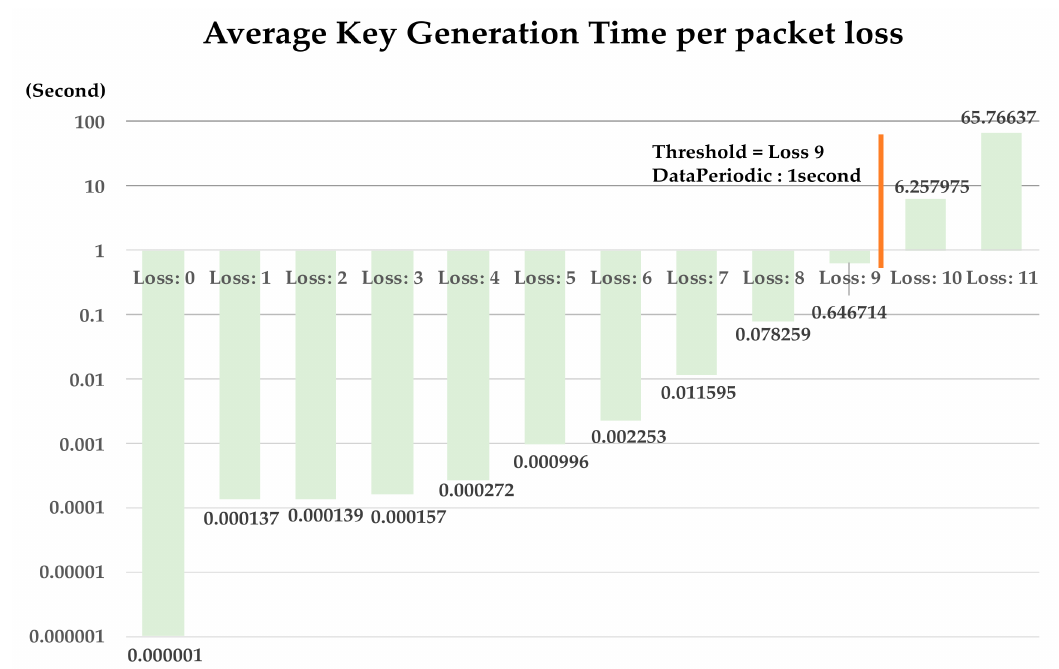
Figure 11. Experiment result of Section